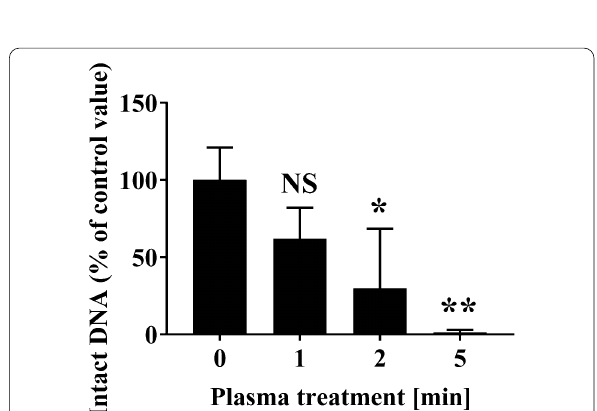
Fig. 4 Changes to fungal DNA (28S rDNA) of A. brasiliensis spotted onto an aluminium plate following APDBD treatment. The level of intact 28S rDNA from A. brasiliensis spotted onto an aluminium plate was quantified by real-time PCR. The level of the corresponding amplified product for the 0 min sample was assigned a value of 100%. Differences where p < 0.05(*) and p < 0.01(**) versus Control (0 min) were considered significant when verified by the non-repeated measured ANOVA followed by the Bonferroni correction. NS means no significant difference compared to Control (0